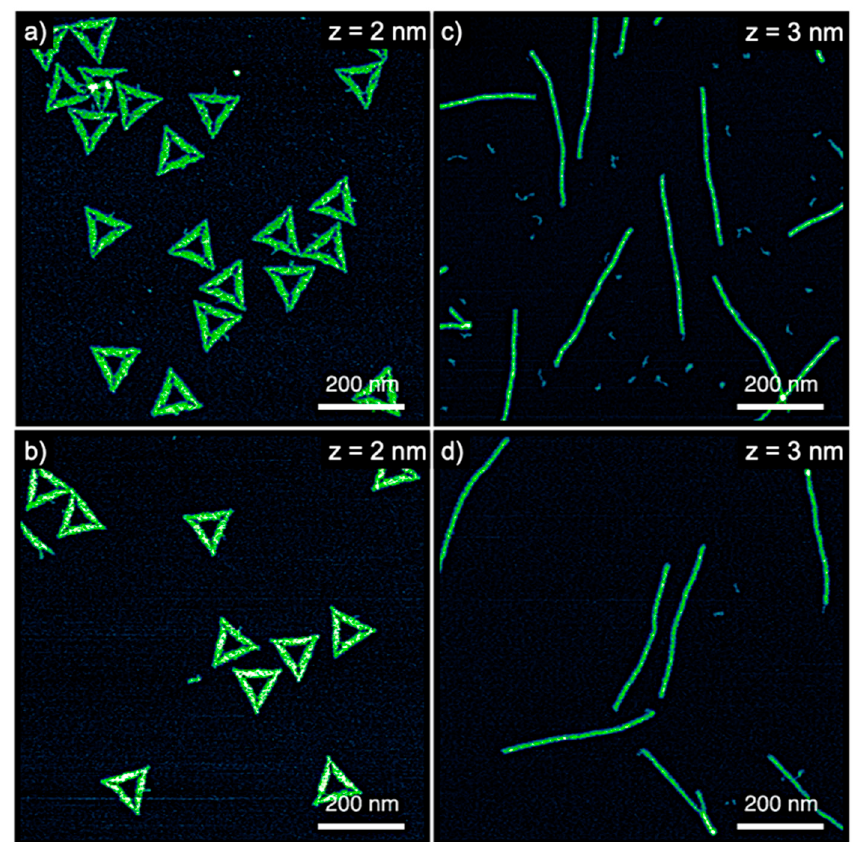
Figure 1. Atomic force microscopy (AFM) images of ( a , b ) DNA origami triangles and ( c , d ) 6HBs incubated in buffer ( b , d ) with and ( a , b ) without 10% DMSO. The ranges of the z-scales are given in the individual images.